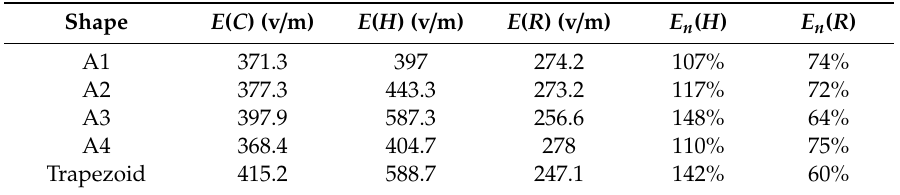
Table 1. Simulation results; the resistor shapes are shown in Figure